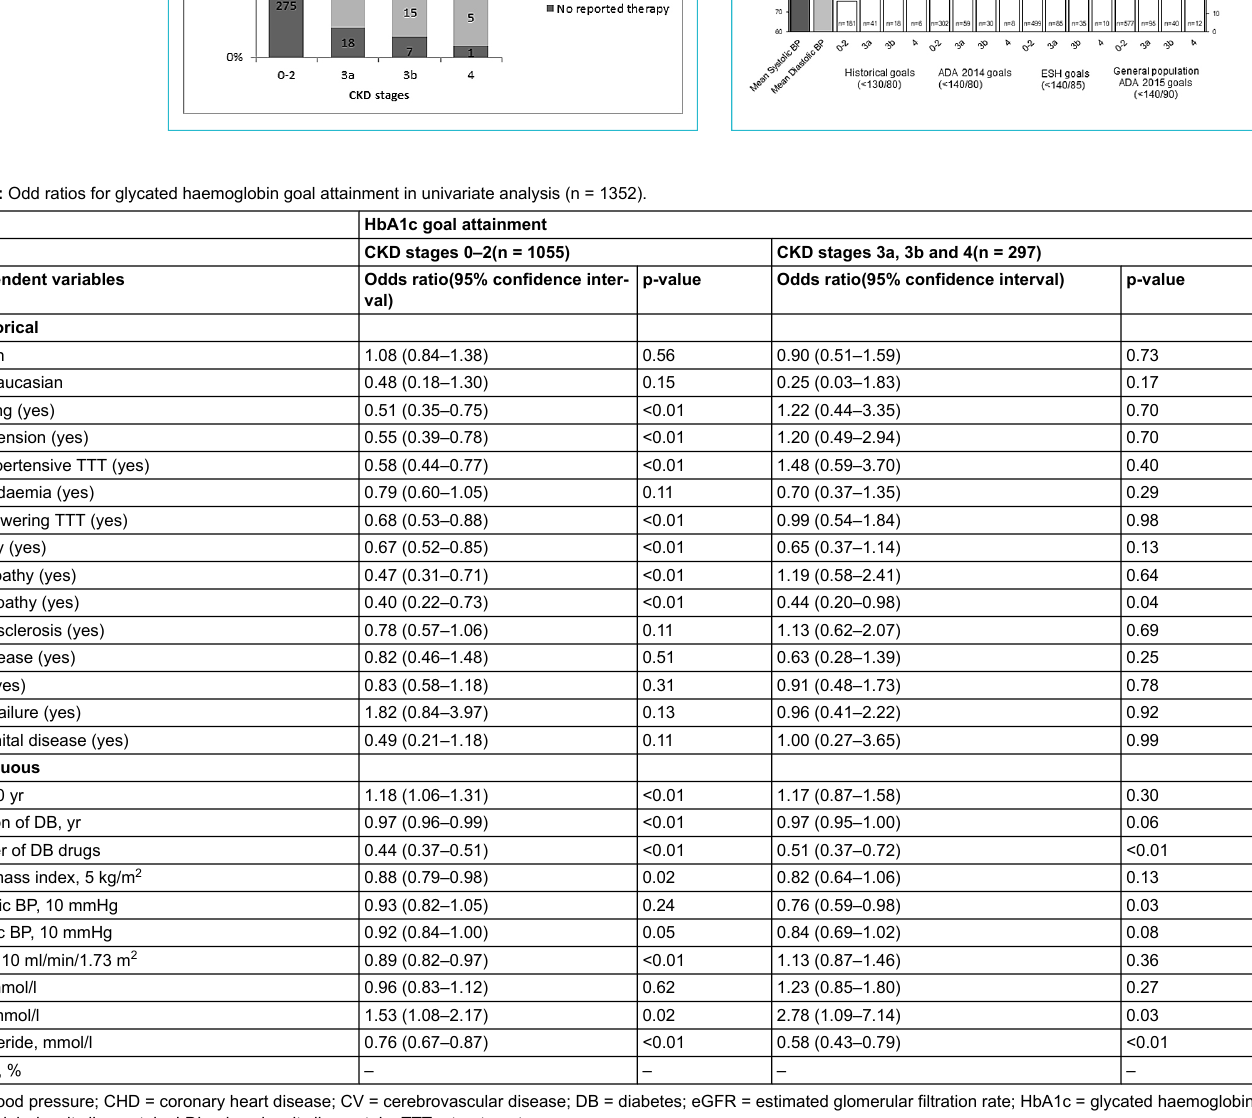
Figure 3: Mean blood pressure and number (%) of patients achieving blood pressure goals according to guidelines.ADA =